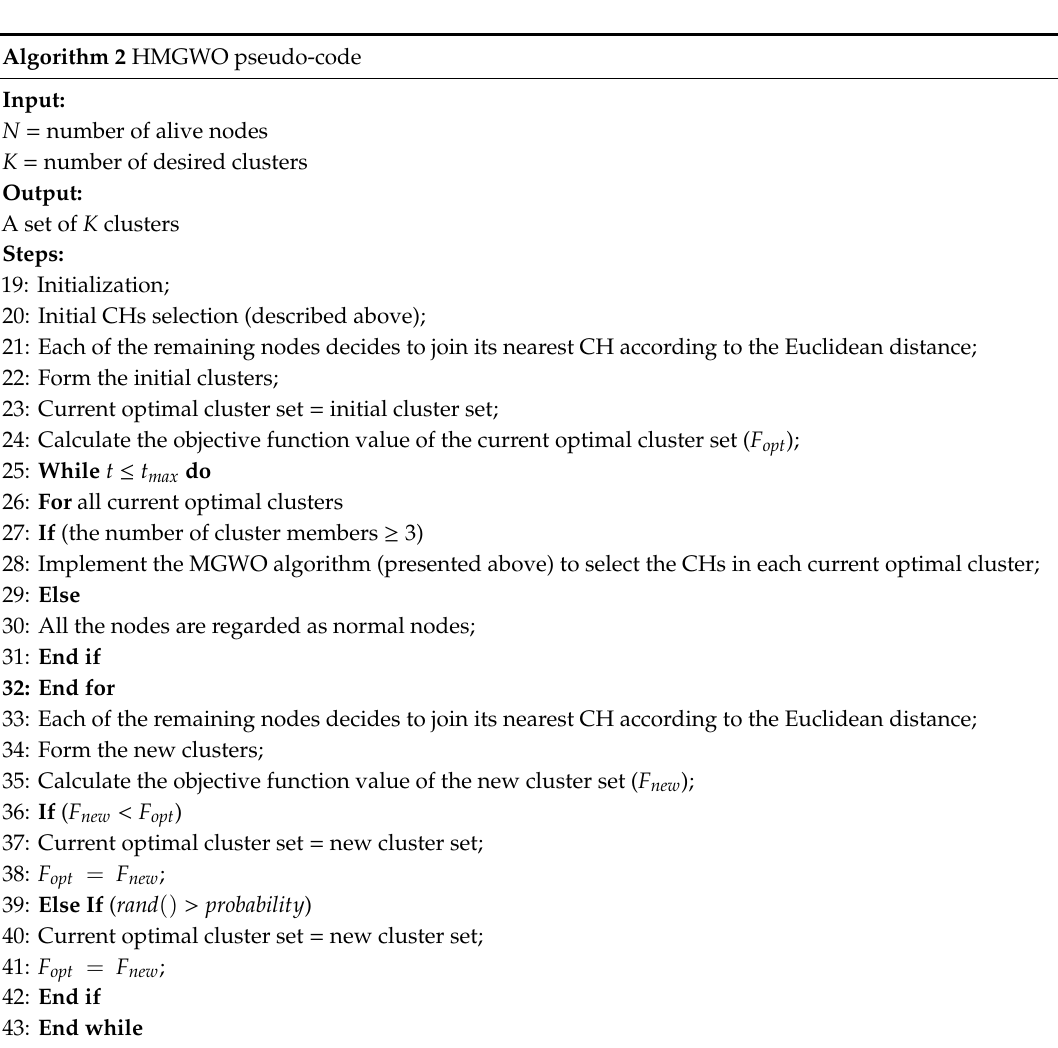
Algorithm 2 HMGWO pseudo-code